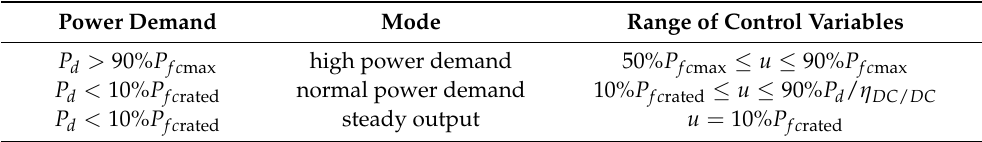
Table 4. Fuel cell working